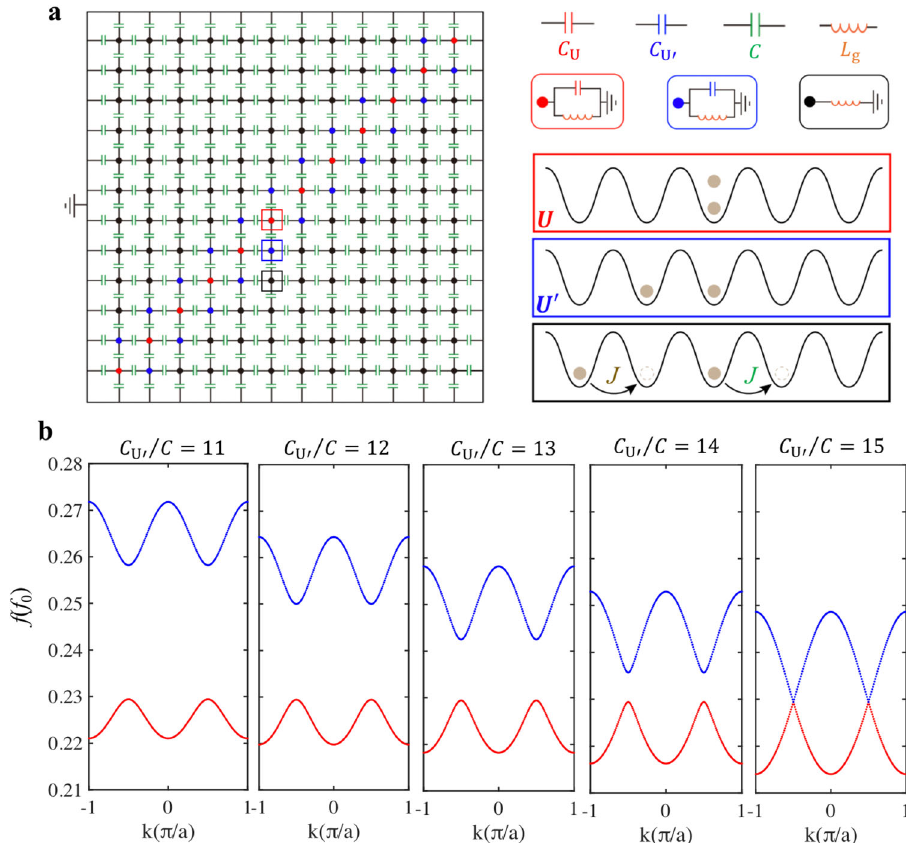
Fig. 1 The designed electric circuit for simulating interaction-induced relativistic effects. a The top view of the designed 2D circuit. The red, blue and black nodes represent the circuit nodes corresponding to the probability amplitude of two-bosons in the same site, nearest neighbor sites and distant sites, respectively, as illustrated by three bottom insets. The top insets present the grounding setting of different circuit nodes framed by box with the same color. b The Dirac-like dispersion curves of designed circuit (in the unit of f 0 ) for the two-boson bound states. The circuit parameters are chosen as C = C ¼ 15 and C = C ¼ 11 – 15. C C fi rst lateral U and U U 0 U 0 are grounding capacitors on the main and